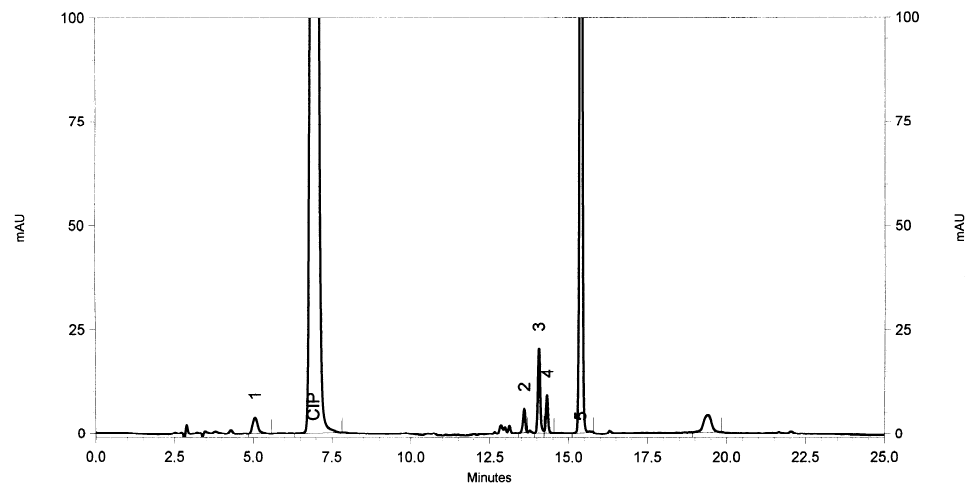
Figure 3. Chromatogram of the CIP oxidized by ACVA after incubation for 336 h at 40 °C.